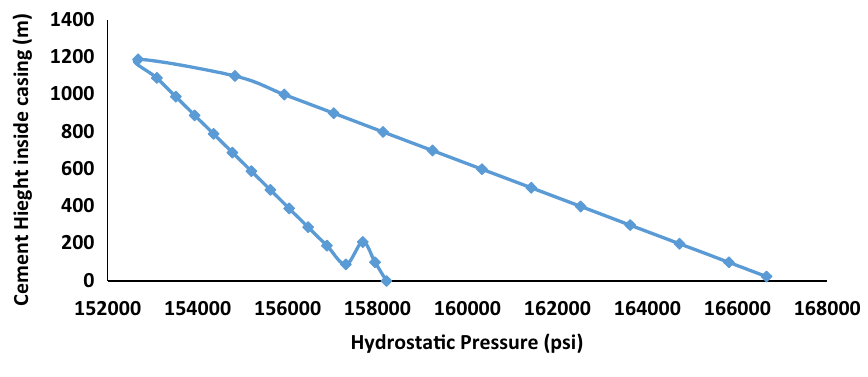
Fig. 4 Variations of Buoyancy force during cement displace-